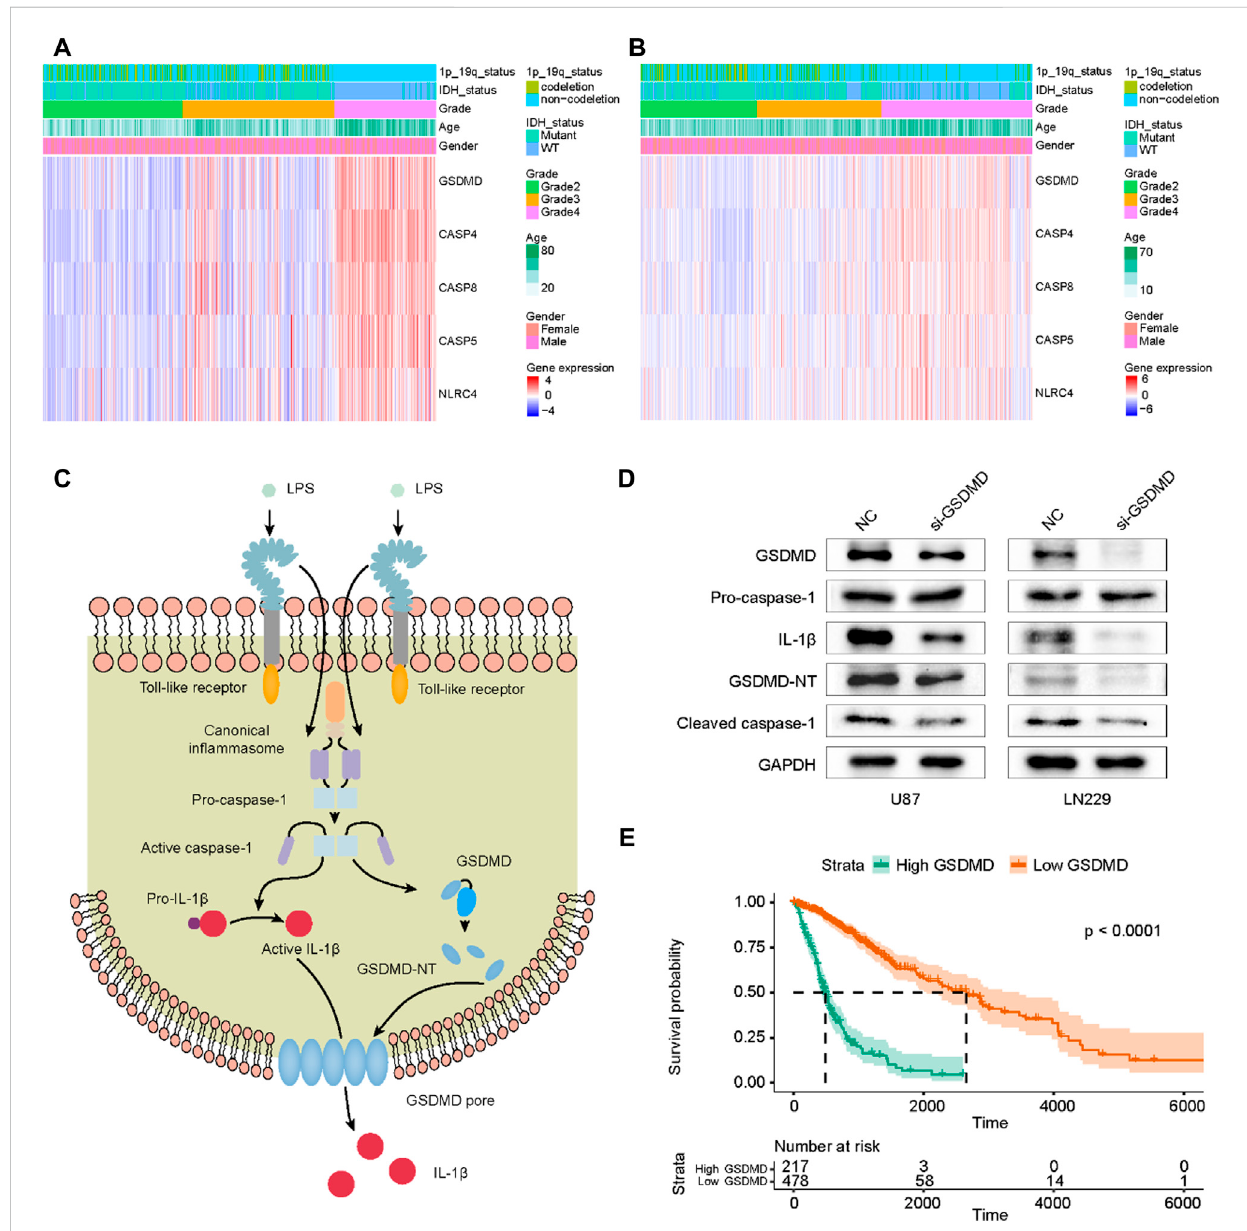
FIGURE 8 Pro fi le ofsignature genesexpression ingliomasandfunctionalvalidation ofGSDMD inpyroptosis. (A) The heatmap of fi vePRGsinTCGA cohort. (B) Theheatmapof fi vePRGsinCGGAcohort. (C) TheGSDMD-dependentpyroptosissignalingpathwayregulatedbycaspase-1. (D) AftersiRNAtransfection, the expressions of GSDMD, Pro-caspase-1, IL-1 β , GSDMD-NT and cleaved caspase-1 were detected by Western Blot. (E) Correlation of GSDMD expression level with glioma